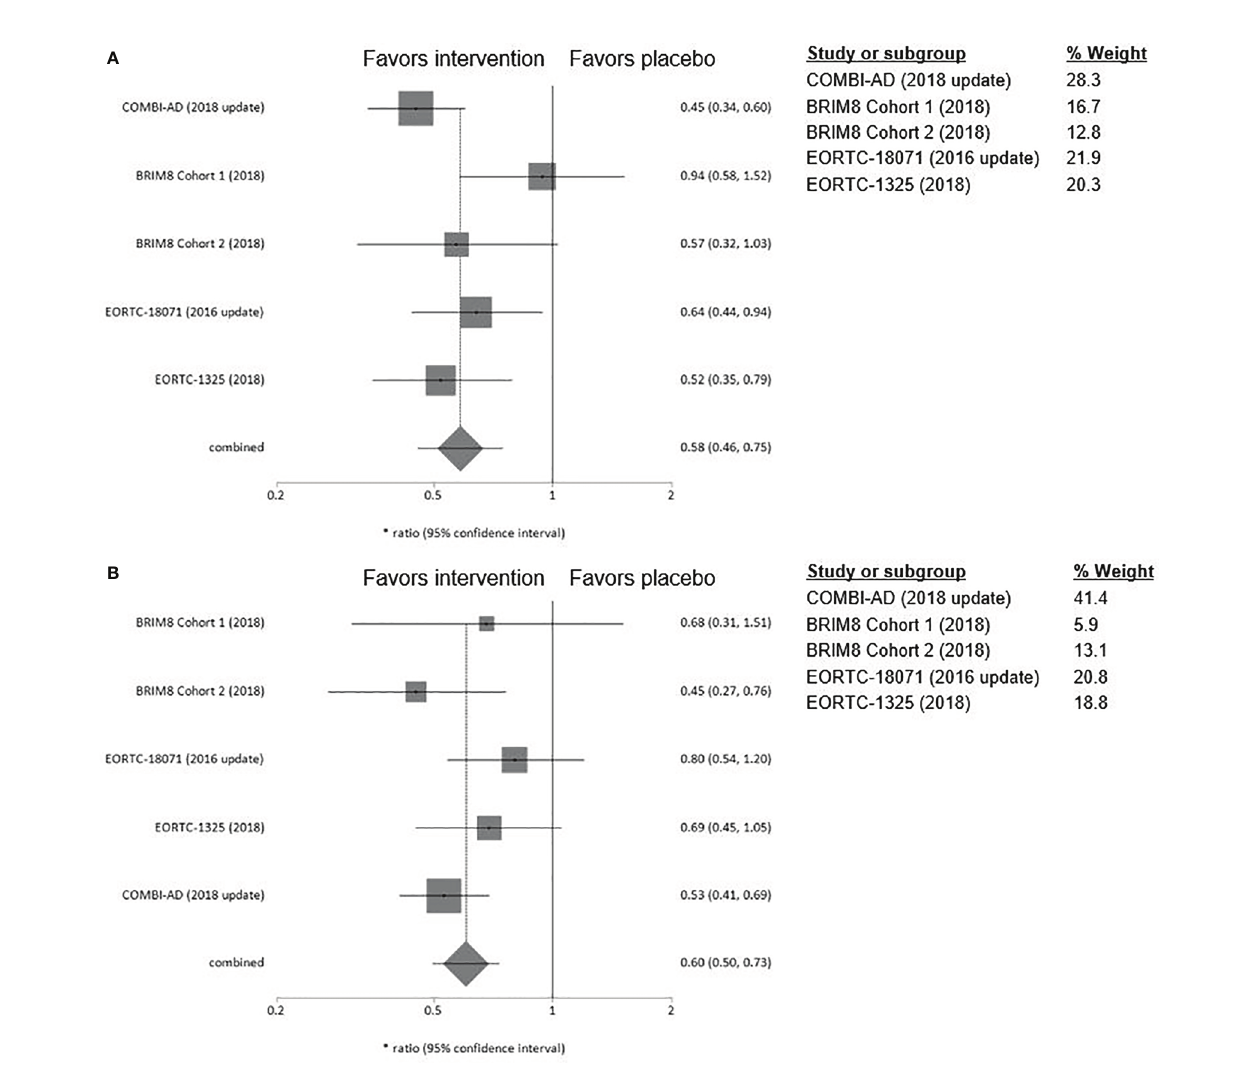
FIGURE 4 | (A) Forest plot for primary outcome analysis on relapse free survival for patients with ulcerated primary tumor . (B) for patients with non-ulcerated primary tumor. Hazard ratio for relapse or death along the x-axis, and trial results on the y axis, with gray squares representing effect estimates and lines through them representing 95% CIs. The gray diamond represents the overall effect measure which lies clear of the line off no effect, showing a bene fi t for the treatment groups compared to placebo. The percentage weight for each study is separately listed on the right of the graph. CI, con fi dence